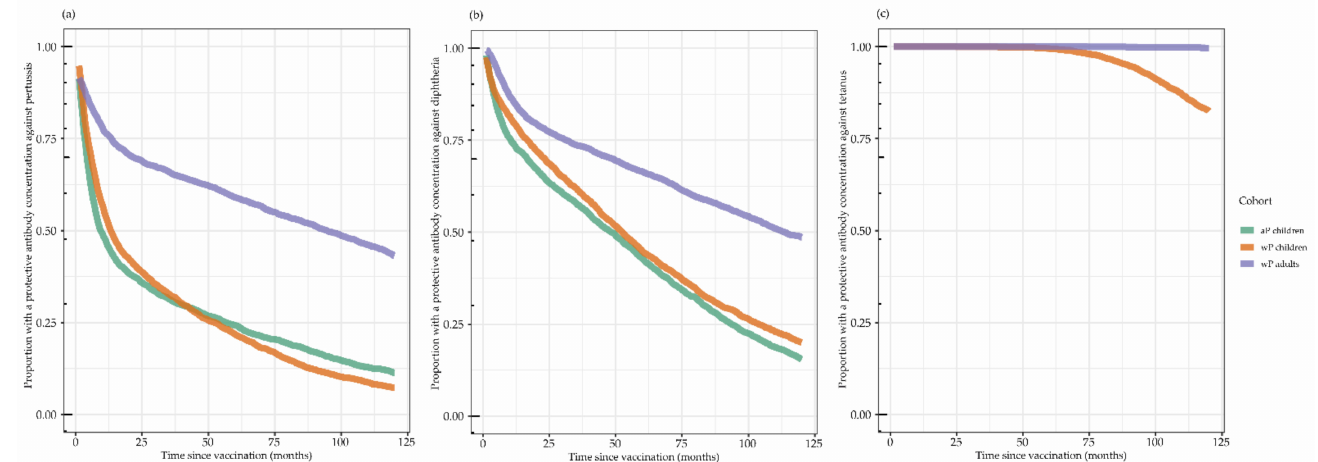
Figure 3. The modelled proportion with protective antibody concentrations is based on the antibody decay model (Figure 2). For pertussis toxin, an arbitrary cut-off of protection of ≥ 20 IU/mL was used. For both diphtheria toxoid and tetanus toxin, the WHO cut-off for clinical protection of 0.1 IU/mL was used. Acellular primed children are missing in the tetanus toxin model because of interference from another (non-pertussis) vaccine in between the last two timepoints. aP: acellular pertussis; wP: whole cell pertussis. The modelled proportion with protective antibody concentrations for ( a ): pertussis; ( b ): diphtheria; and ( c ):